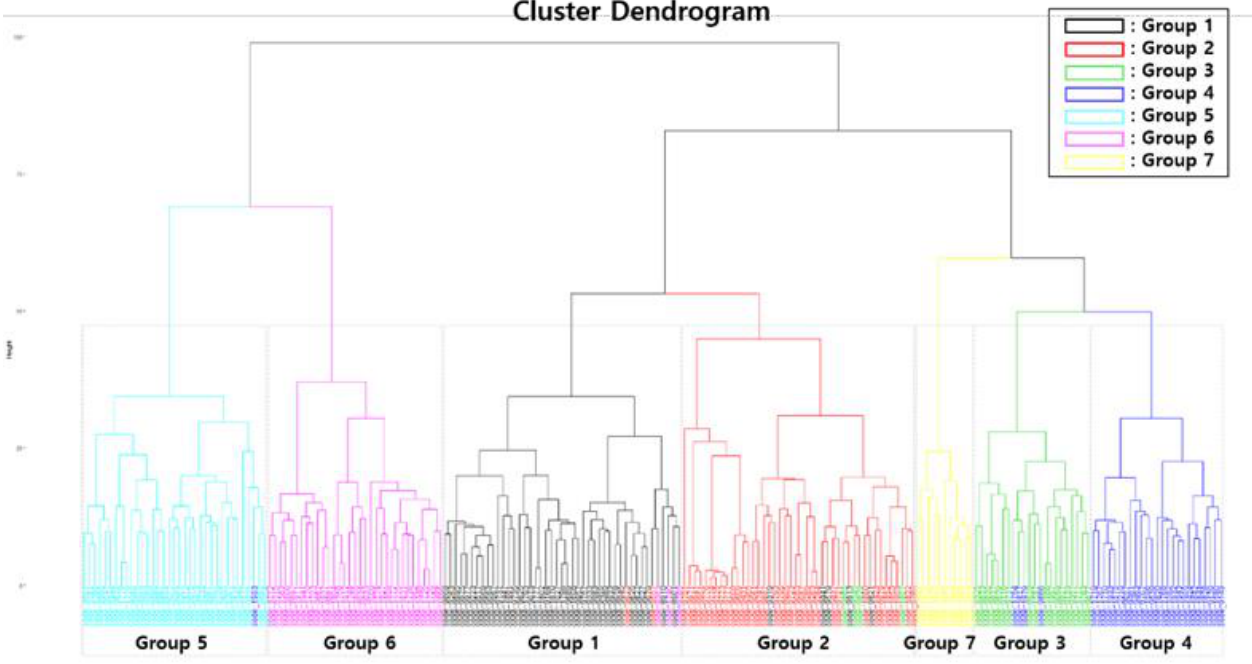
Figure 4. D endrogram of clusters based on standardized solar power generation. Figure 4. Dendrogram of clusters based on standardized solar power